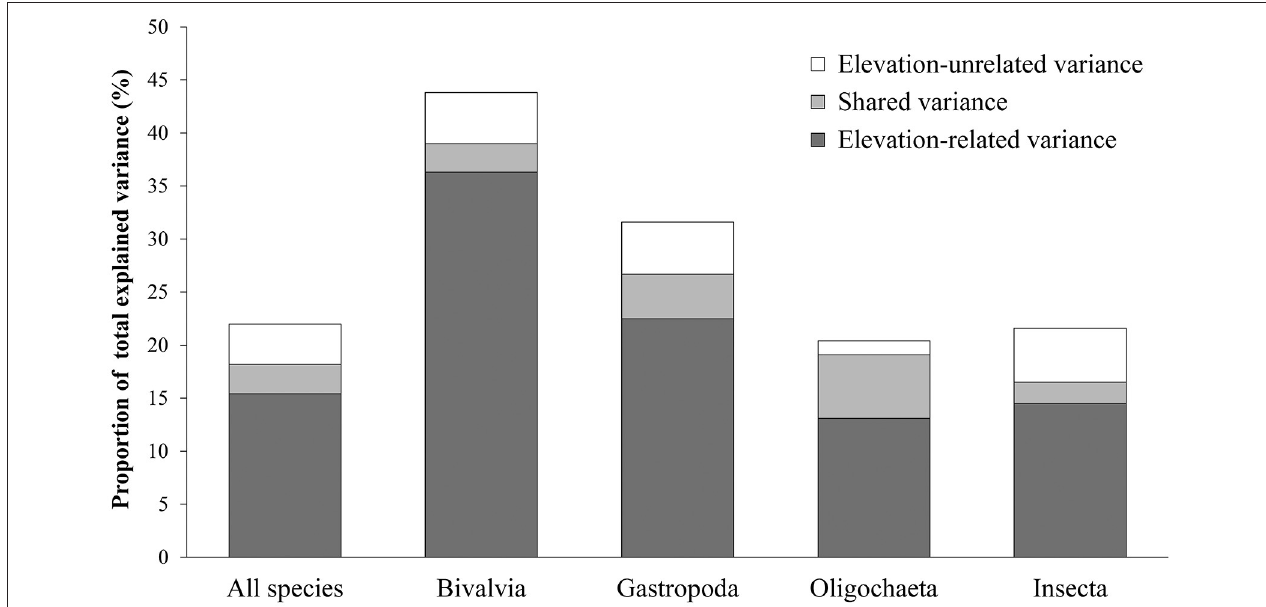
FIGURE 5 | Proportion of total explained variance related to elevation-related variance, shared variance, and elevation-unrelated variance in different groups of benthic macroinvertebrates. Oligochaetes, gastropods, and bivalves were identified to genus or species. Insects were identified to family or